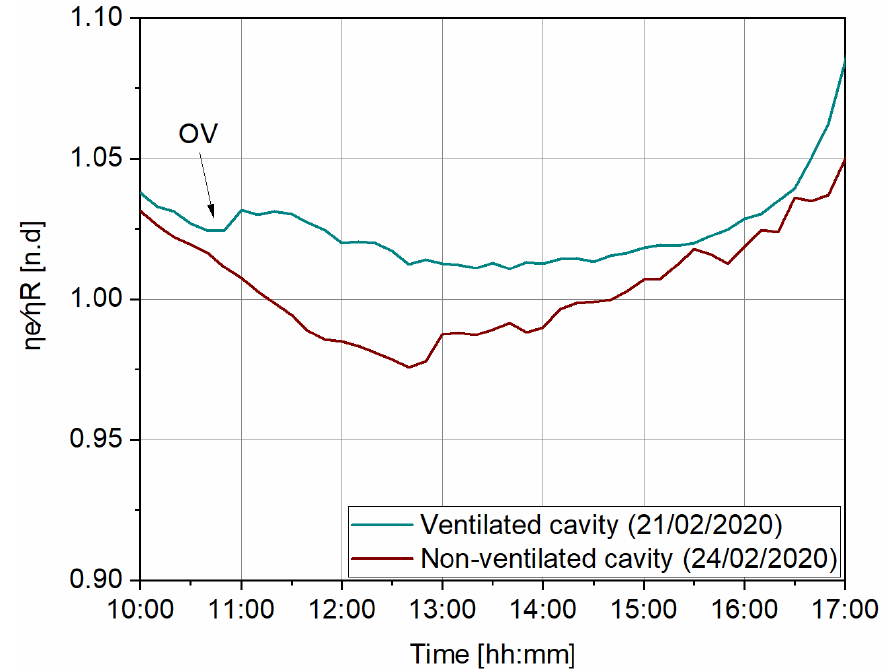
Figure 13. BIPV-WS electrical efficiency behavior for winter conditions.